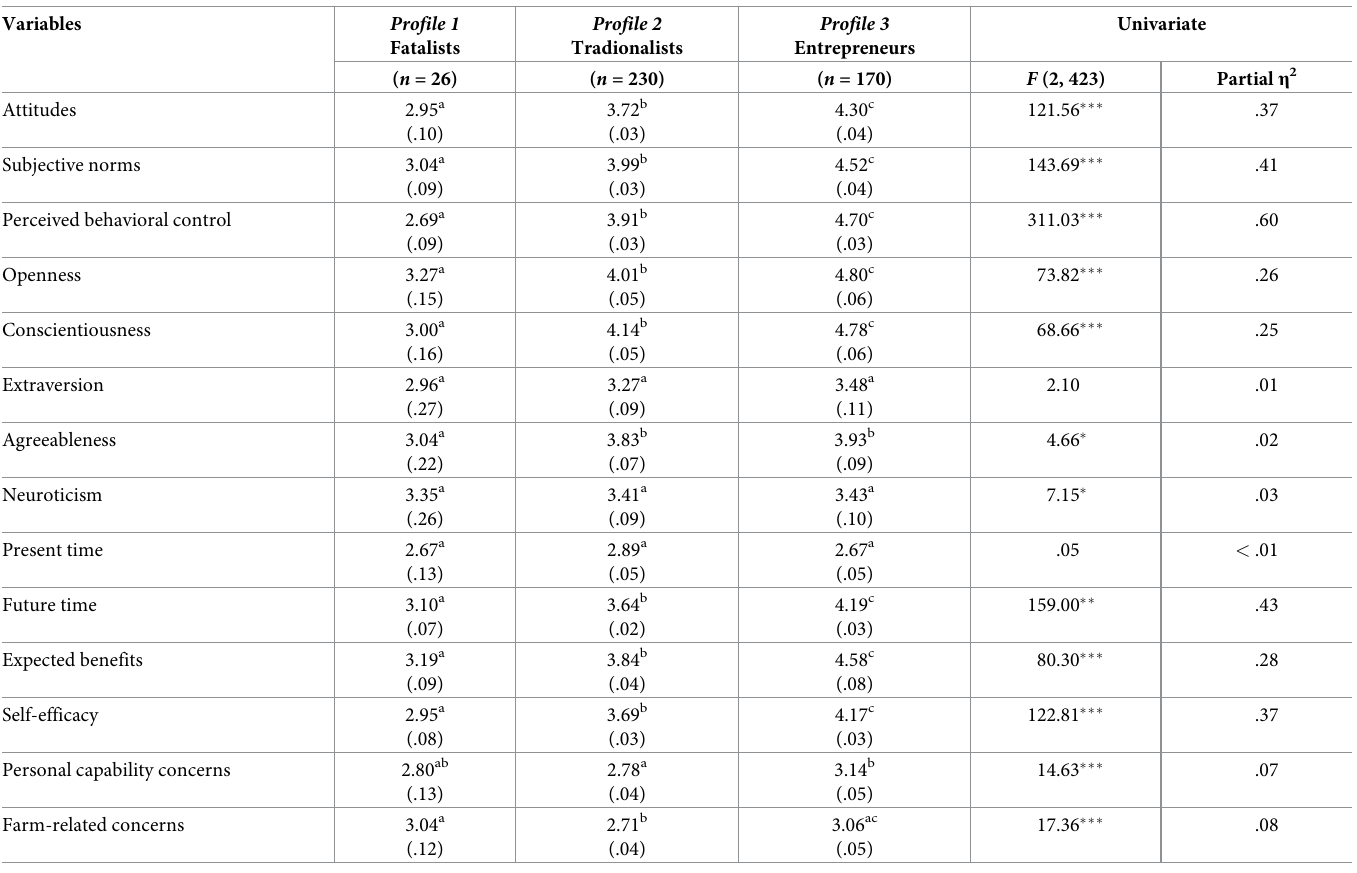
Table 6. Means, standard errors and mean differences across three poultry farmer profiles. Variables Profile 1